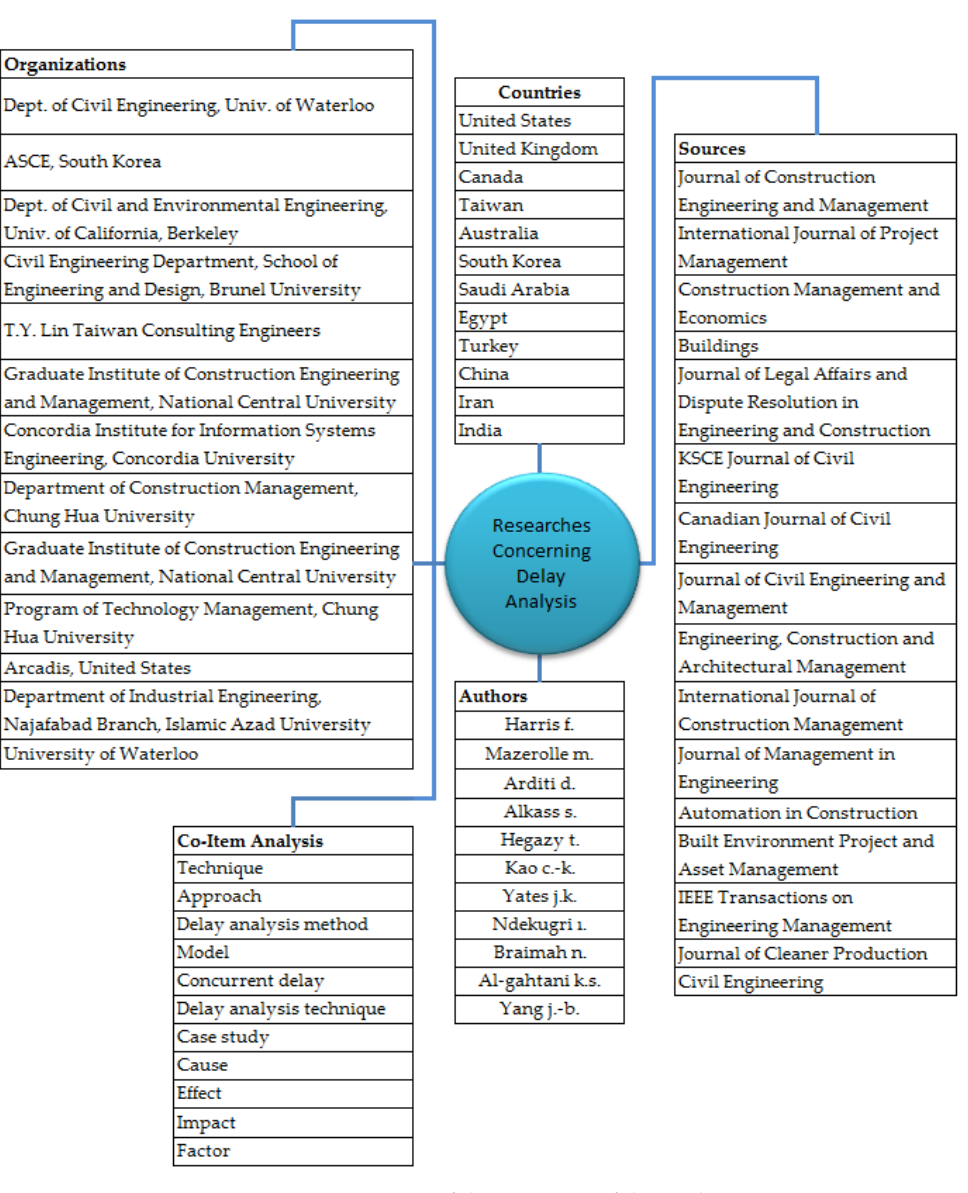
Figure 7. Summary of the outcomes of the